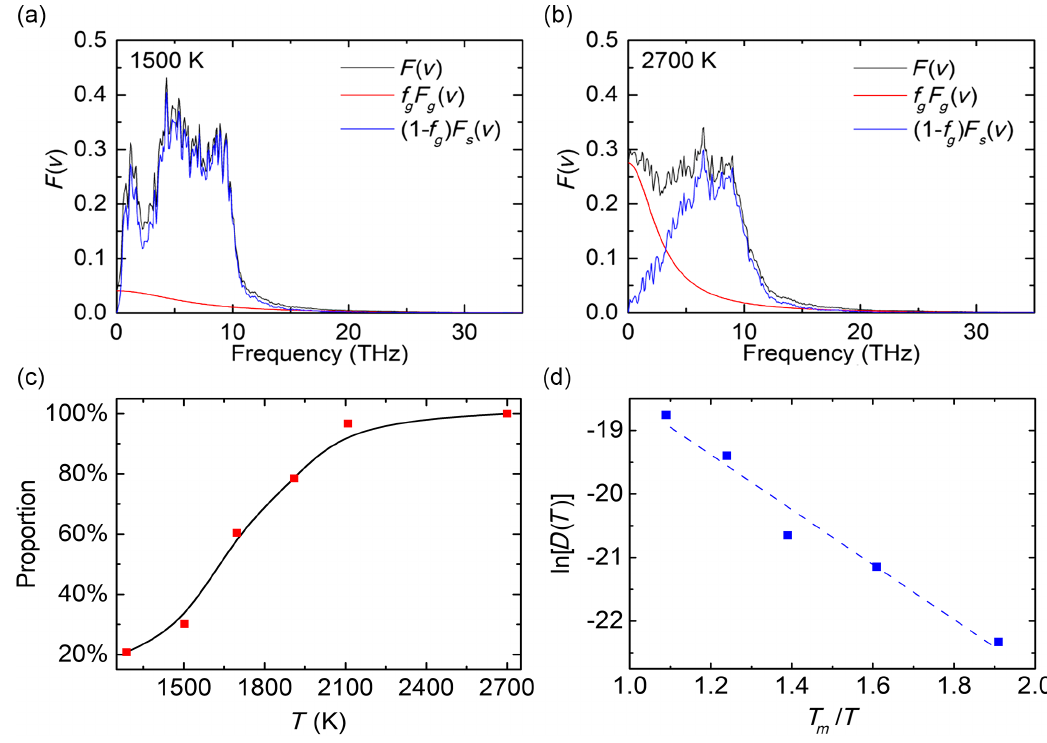
FIG. 2. (a),(b) The decomposition of the normalized density of states for 50 GPa sc calcium at 1500 and 2700 K corresponding to chain melting and liquid, respectively. The 2PT MF solution for gaslike (red solid line) and solidlike (blue solid line) components was generated using the even moments M 2 . (c) The proportion of atoms that contribute to the diffusive chains inside 50 GPa sc Ca at different temperatures. (d) Temperature dependence of Ca self-diffusion due to collective atomic motion in the form of chain